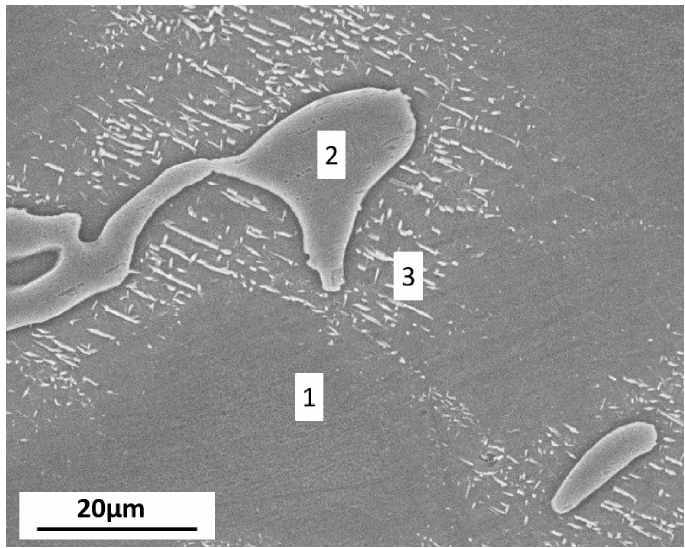
Figure 1. The microstructure of AZ91D.